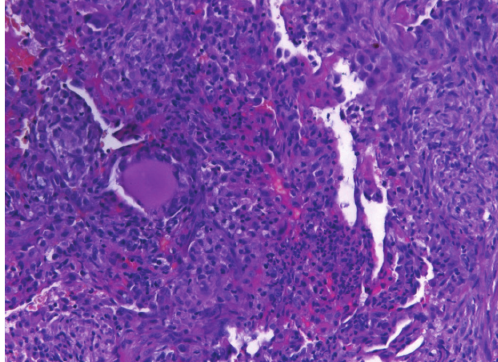
Figure 3: Lung biopsy specimen obtained by video-assisted tho- racoscopic wedge resection (HE × 10). Extensive granulomatous inflammation. No evidence of fibrosis or malignancy.